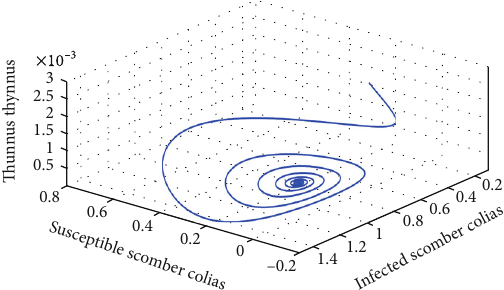
Figure 6: Illustration of the evolution of the susceptible, infected Scomber colias and Thunnus thynnus fi sh population.